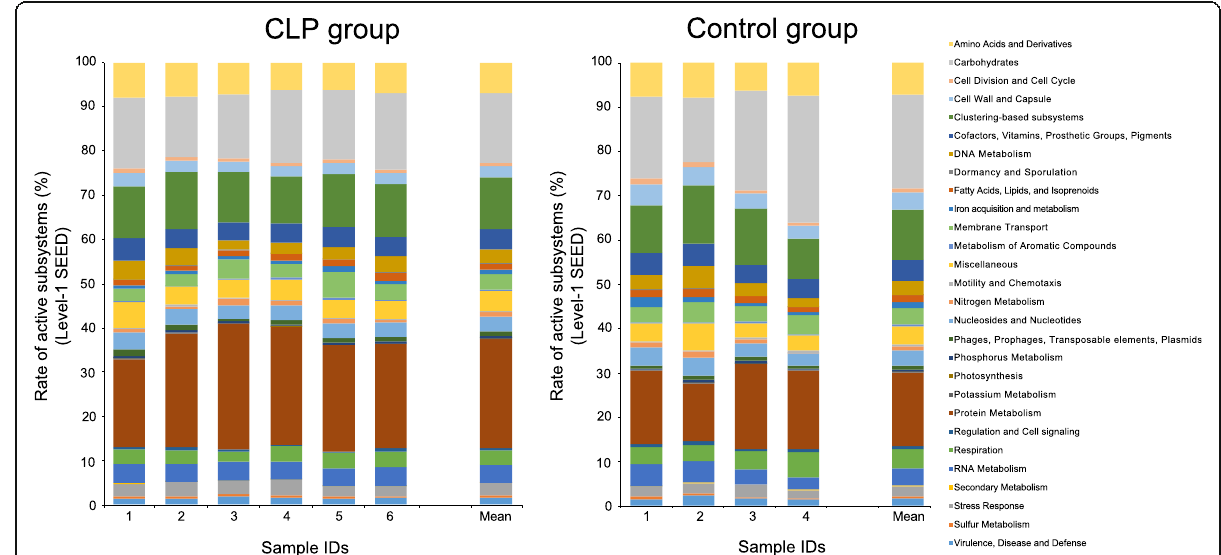
Fig. 2 Functional profiles estimated from mRNA reads with the SEED. The bar charts present gene functions as relative abundances. Each color corresponds to the functions in the level-1 SEED subsystem, indicated on the right